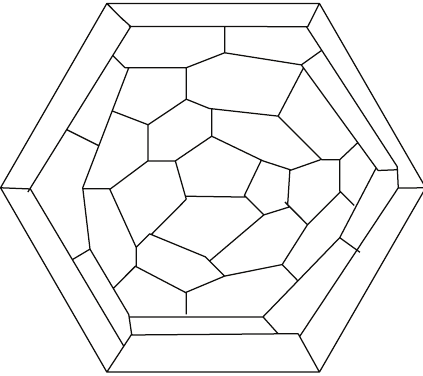
Figure 5: The molecular structure of fullerenes 𝐶 18𝑛+10